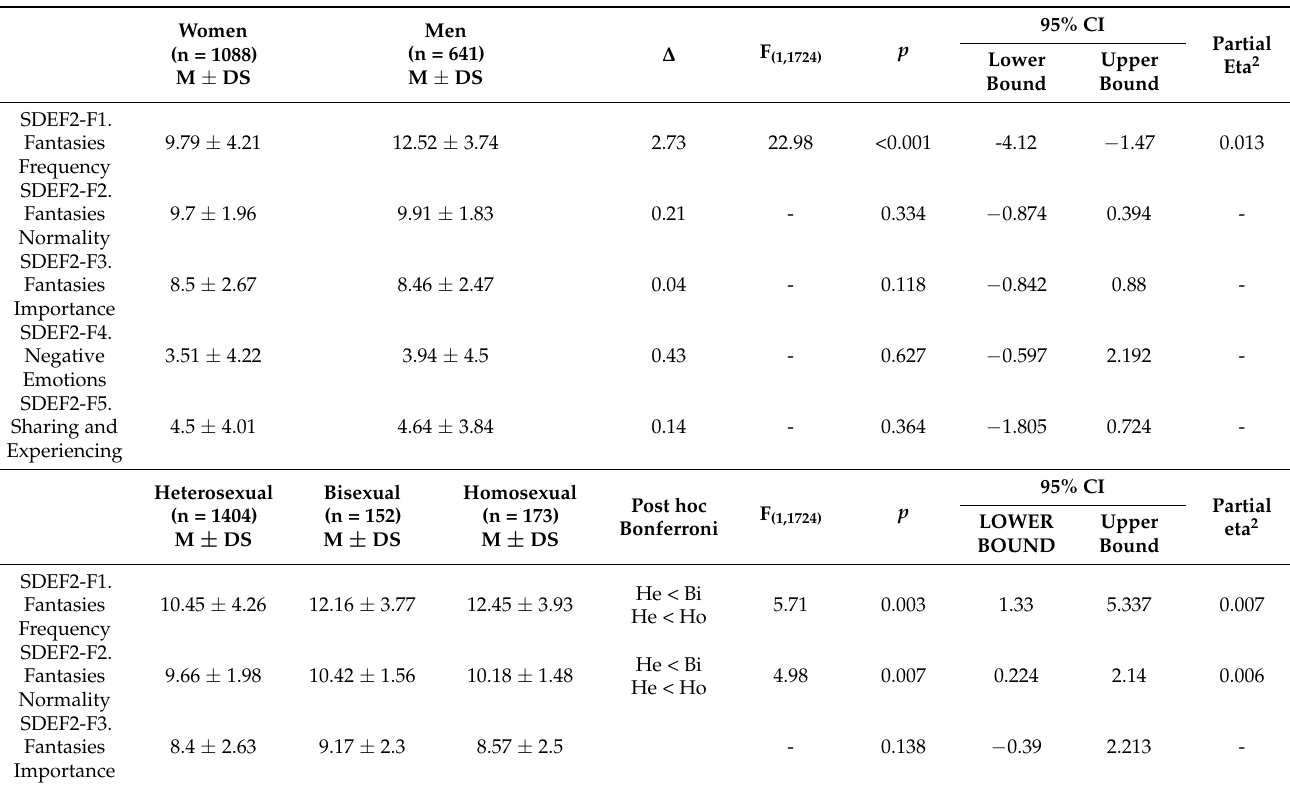
Table 5. MANCOVAs using gender and sexual orientation as independent variables and SDEF2 factors as dependent ones (n =